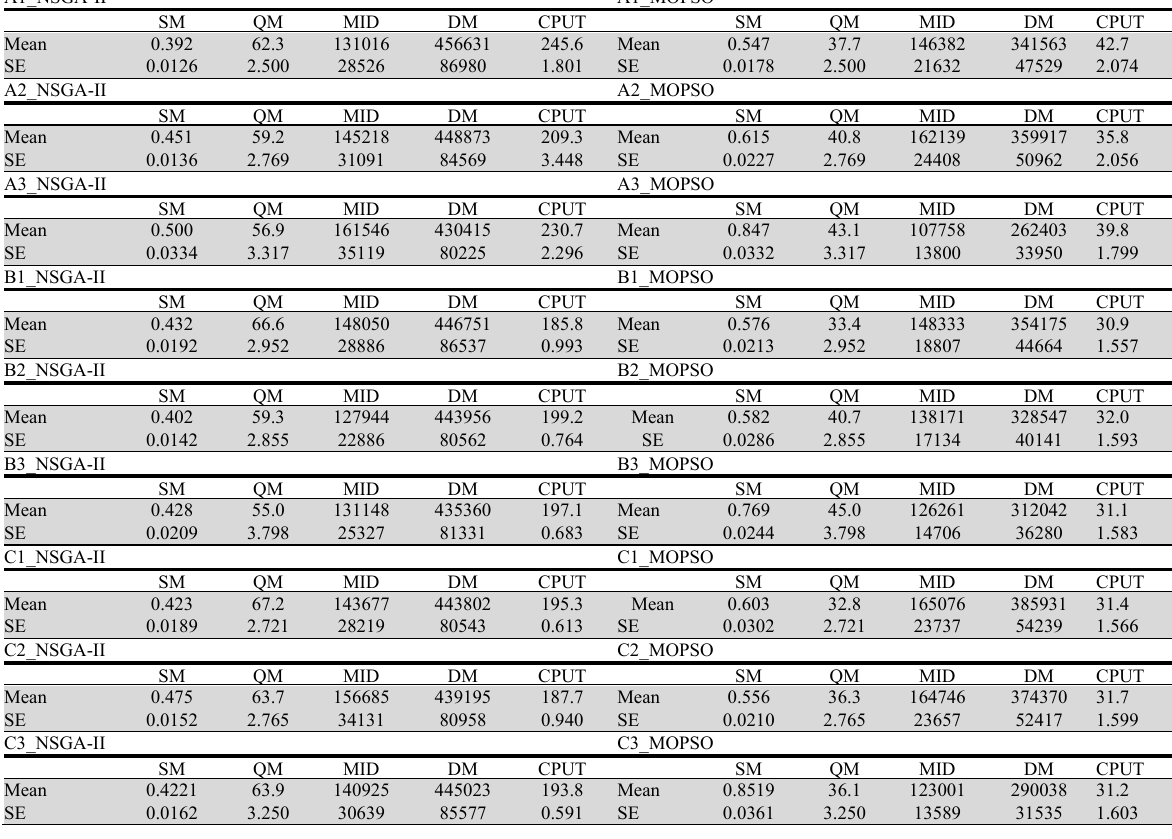
SE and Mean values for the two algorithms in medium and large scale sample problems for each class